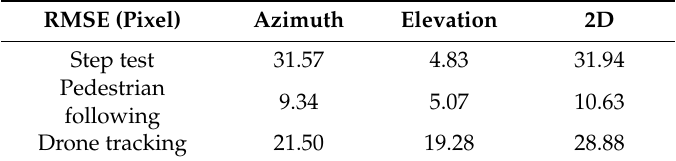
Table 1. Root mean square errors (RMSEs) of boresight errors in different cases.